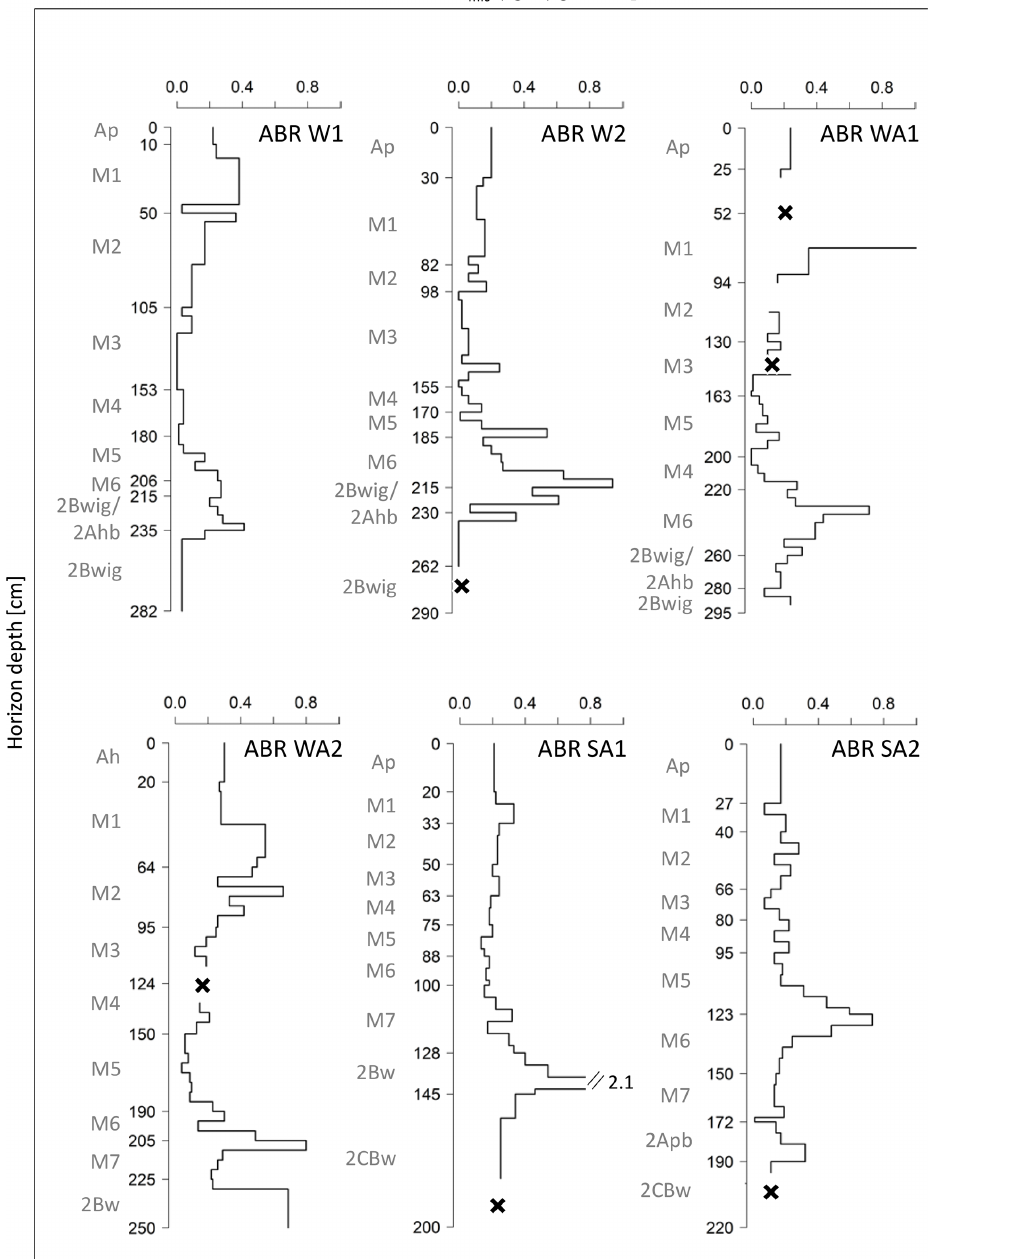
Figure 10. Depth profiles of Urease / C mic ratio of selected colluvial profiles. “x”: not